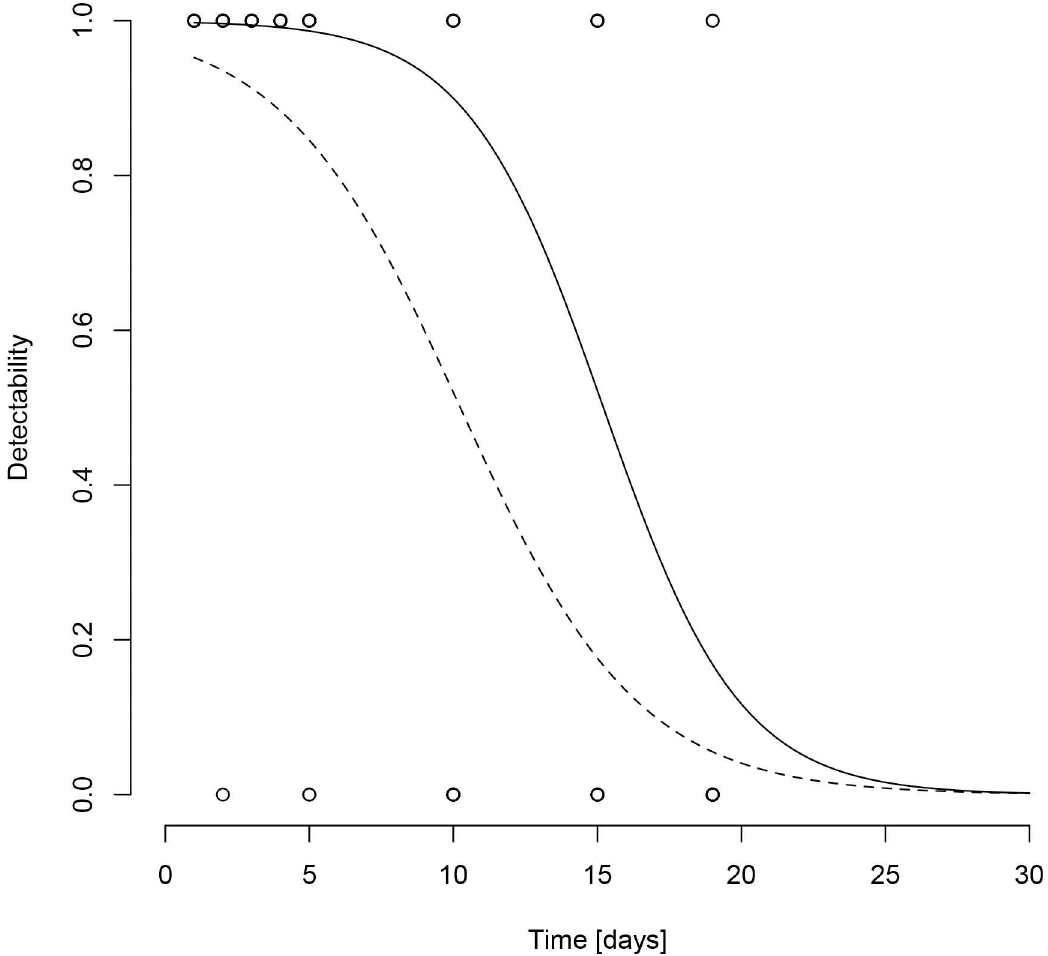
Fig 3. Resultsfrom eDNA persistence experiment. Ae . albopictus eDNA detectability in water as a functionof time afterthe removal of eDNA source material. Circlesare data points. Logistic regressions are given for initialdensitiesof 15 (solidline) and 10 (dashedline)larvaeper